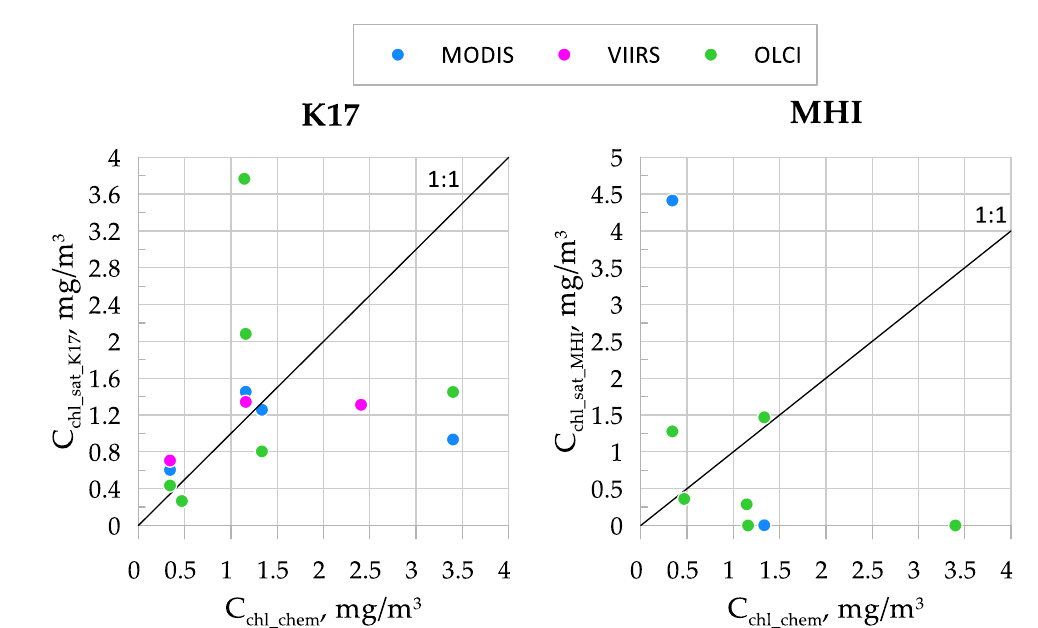
Figure 8. The comparison between measured ( 𝐶 𝑐ℎ𝑙_𝑐ℎ𝑒𝑚 ) and satellite OC4 chlorophyll-a product from MODIS, VIIRS, and OLCI sensors.